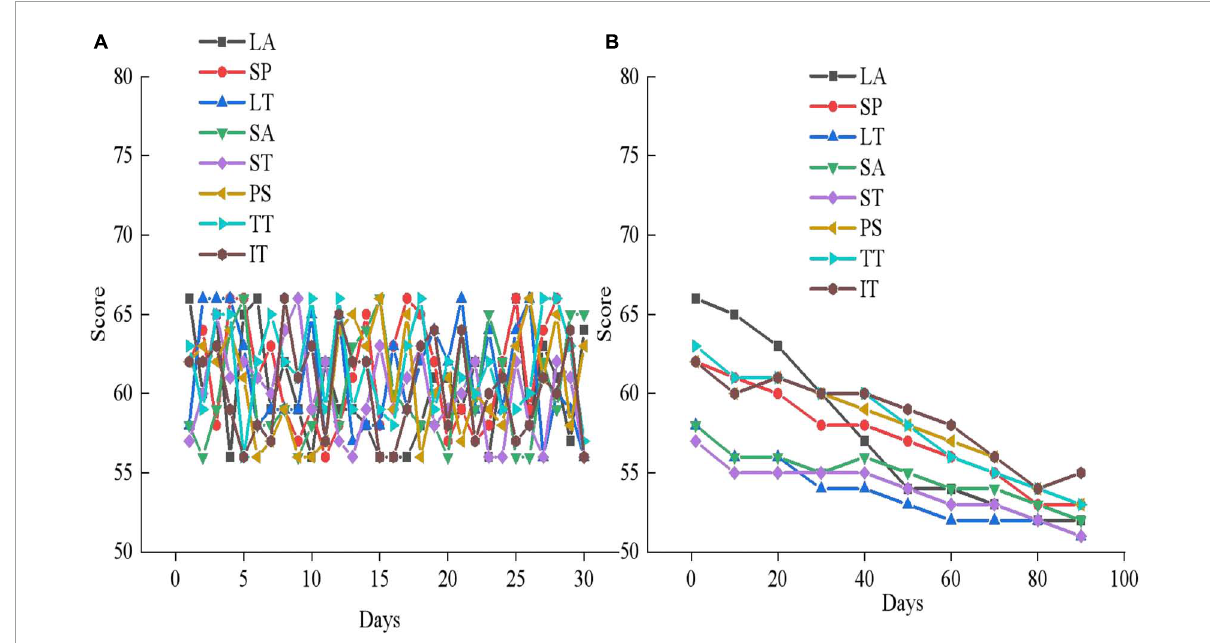
FIGURE12 Mental health outcomes of the experimental group in the first month of therapy. (A) First month mental health assessment results; (B) the mental health changes in experimental group member 1.